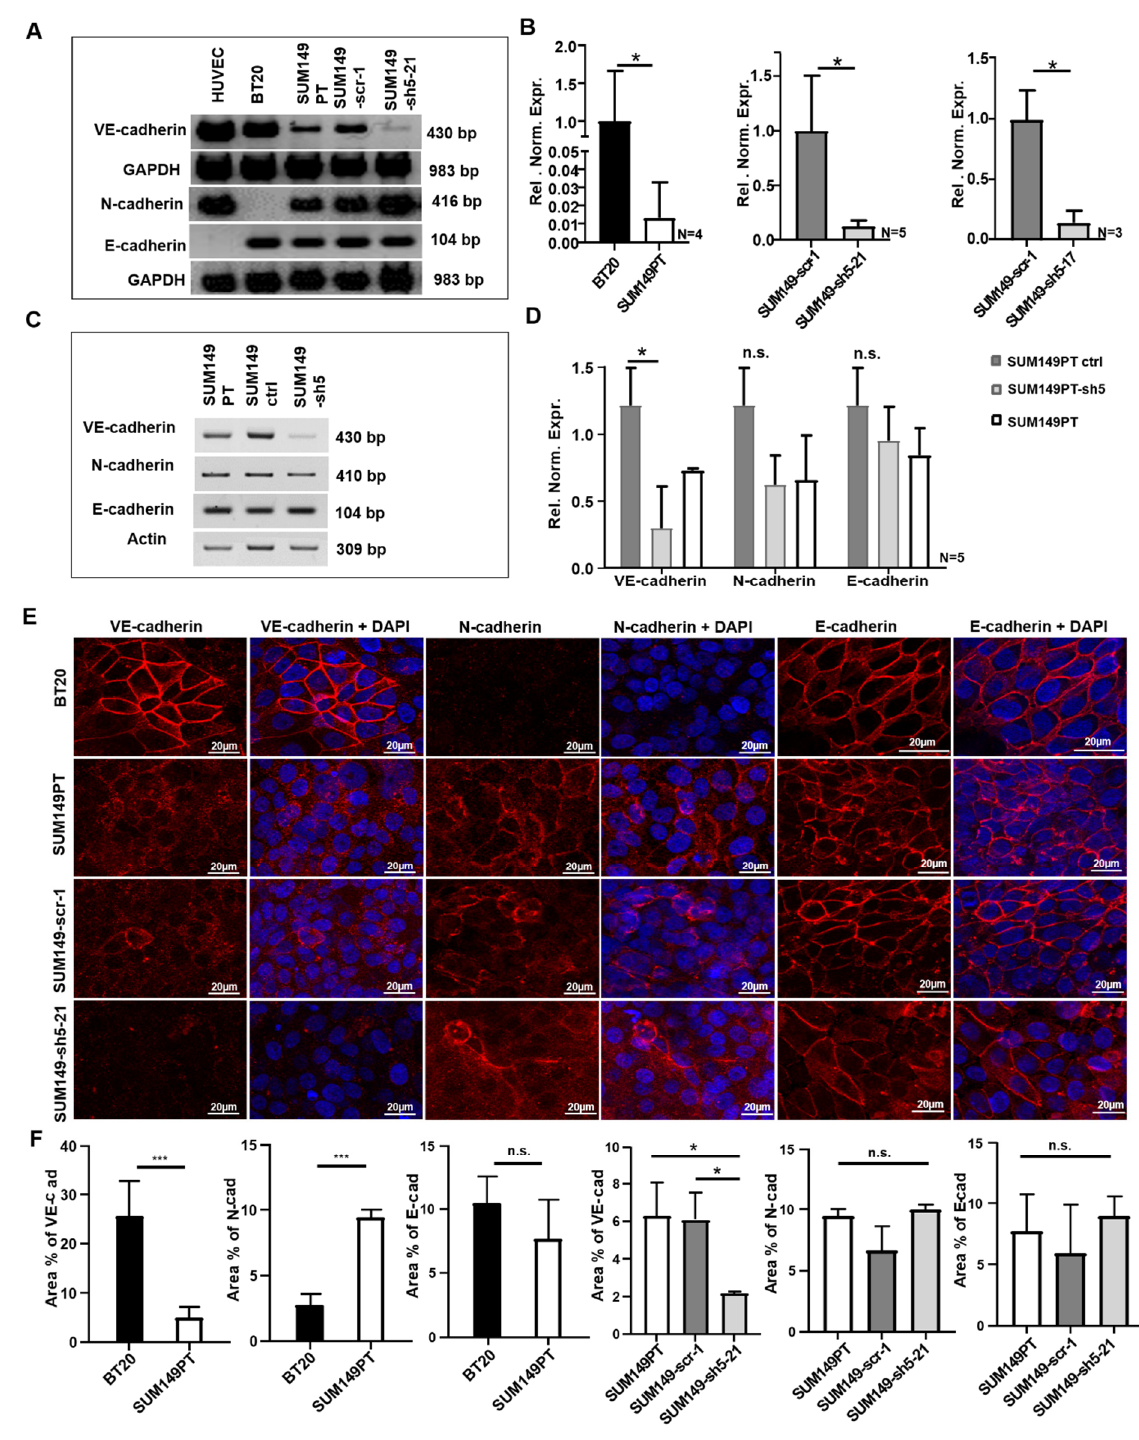
Figure 1. Expression of VE-, N- and E-cadherin in BT20, SUM149PT, SUM149-scr-1, SUM149-sh5-21, SUM149 ctrl and SUM149-sh5 cells, as detected by RT-PCR, qRT-PCR and immunofluorescence analysis. ( A ) VE-, N- and E-cadherin mRNA expression by RT-PCR. ( B ) Quantification of VE-cadherin mRNA by qRT-PCR. Relative normalized expression (Rel. Norm. Expr.). ( C ) VE-, N- and E-cadherin mRNA expression as observed by RT-PCR. ( D ) Quantification of VE-, N and E-cadherin mRNA by qRT-PCR. Relative normalized expression (Rel. Norm. Expr.). ( E ) Immunofluorescence analysis of VE- N-, and E-cadherin. Nuclear staining with DAPI, 40x magnification ( F ) Area in percent (area in %) positive for VE-, N-and E-cadherin immunofluorescence. For calculation, two to five random spots of the images were used. Bars represent standard deviation; n.s. not significant, * p < 0.5, *** p ≤ 0.001; statistical analysis was conducted using unpaired Welch’s t -tests.